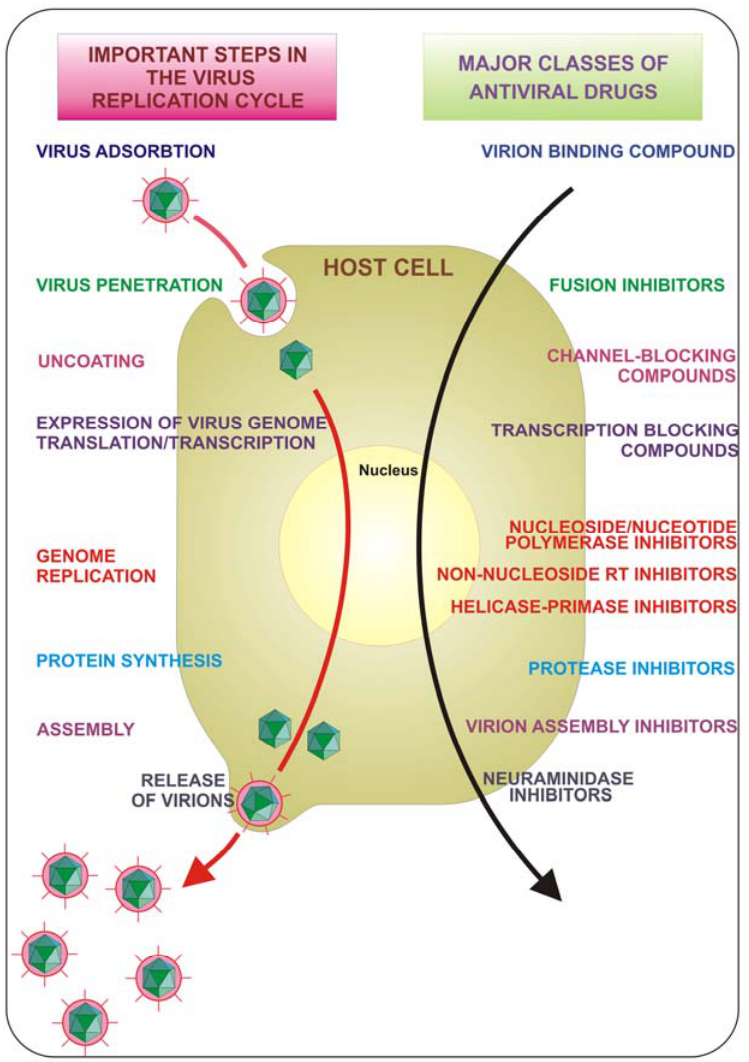
Figure 1. Key steps in the virus replication cycle that provide antiviral